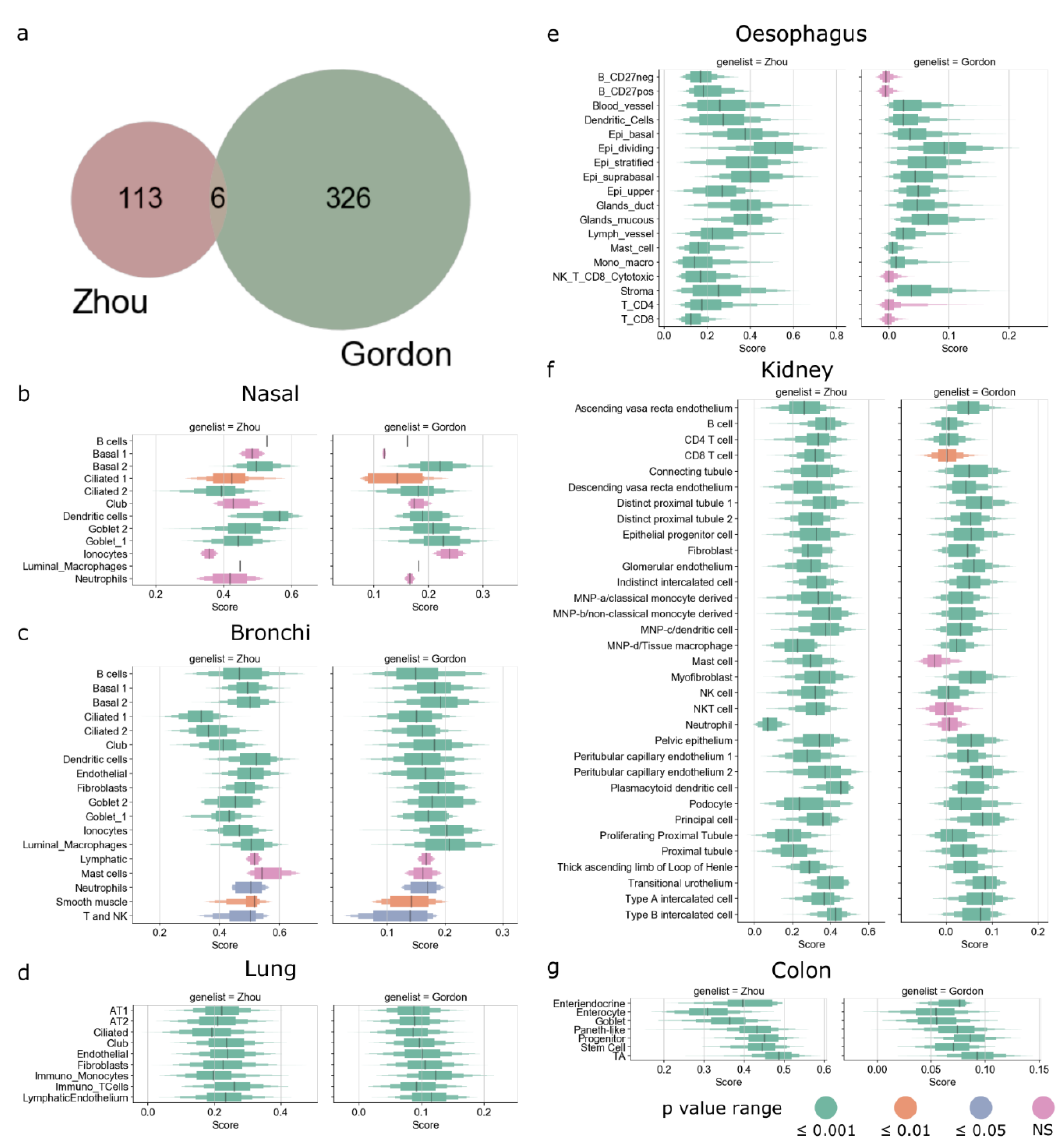
Figure 2. SARS-CoV-2 host factor genes. ( a ) Venn diagram showing overlap of SARS-CoV-2 host factor genes between the Zhou and Gordon gene lists. Boxplot showing the distribution of gene score of Zhou and Gordon genes for different cell types: ( b ) nasal, ( c ) bronchi, ( d ) lung, ( e ) esophagus, ( f ) kidney, and ( g ) colon. Black line represents median, height of box corresponds to number of cells in score range. Color of the box corresponds to the Wilcoxon p value computed with the alternative set to >0. See bottom right of Figure 2 for p value range.